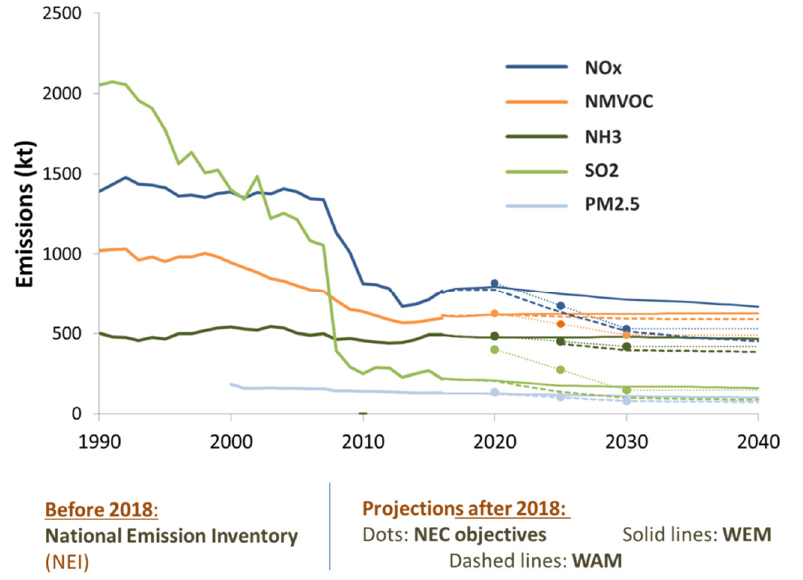
Figure 1. Evolution of NO x , SO x (as SO 2 ), NH 3 , NMVOC, and PM2.5 emissions in Spain taken from the National Emission Inventory produced by the Ministry for the Ecological Transition and Demographic Challenge for the period 2000–2018 (solid lines up to 2018), Commitments under the NEC Directive (dash-dotted lines, values for 2020 and 2030, with 2005 as the reference year) and projected emissions for the WEM and WAM scenarios for 2020, 2025, and 2030 (solid and dashed lines, respectively).